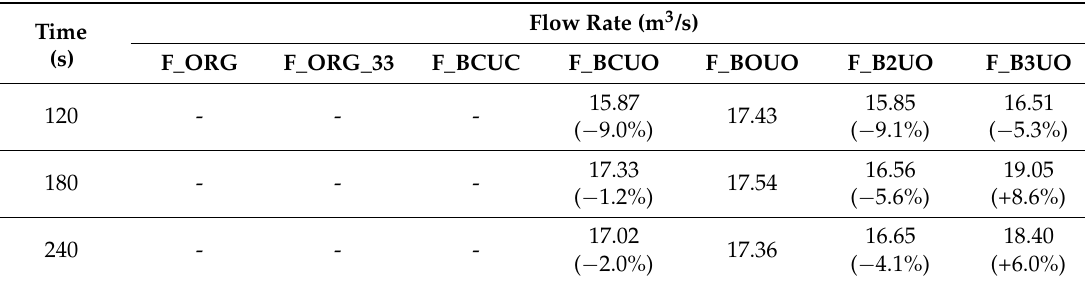
Table 10. Flow rate of the smoke exhaust port